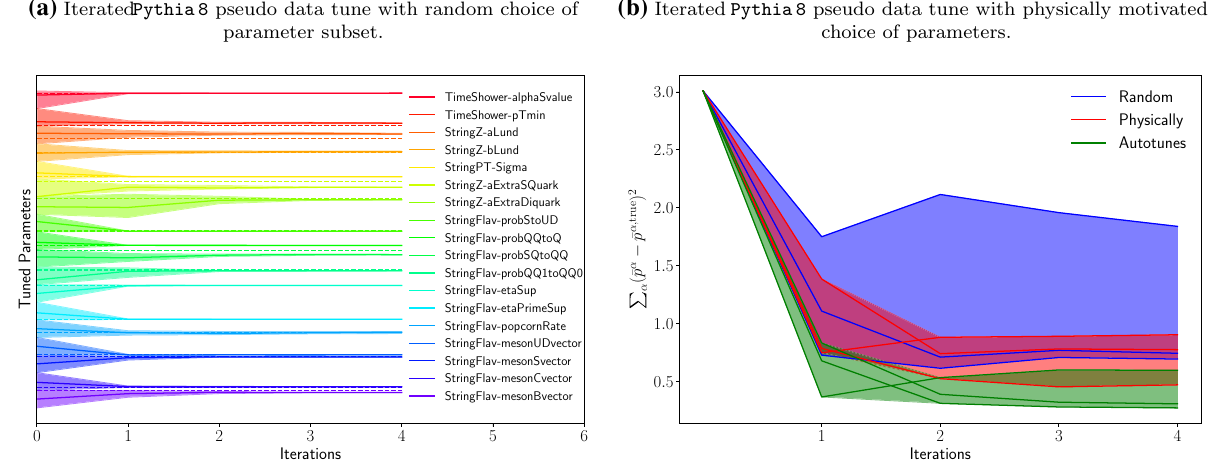
( d ) Comparison in summed deviation from true parameters, each normalized to a range between 0 and 1. Iterating the Autotunes approach leads to better agreement with initially chosen parameters. bands are given by 80% of the best fit values in the Professor run- combinations and an additional 20% margin. In Fig. 5d we compare the the summed deviation for three distinct tunes for the random, physically motivated and Autotunes